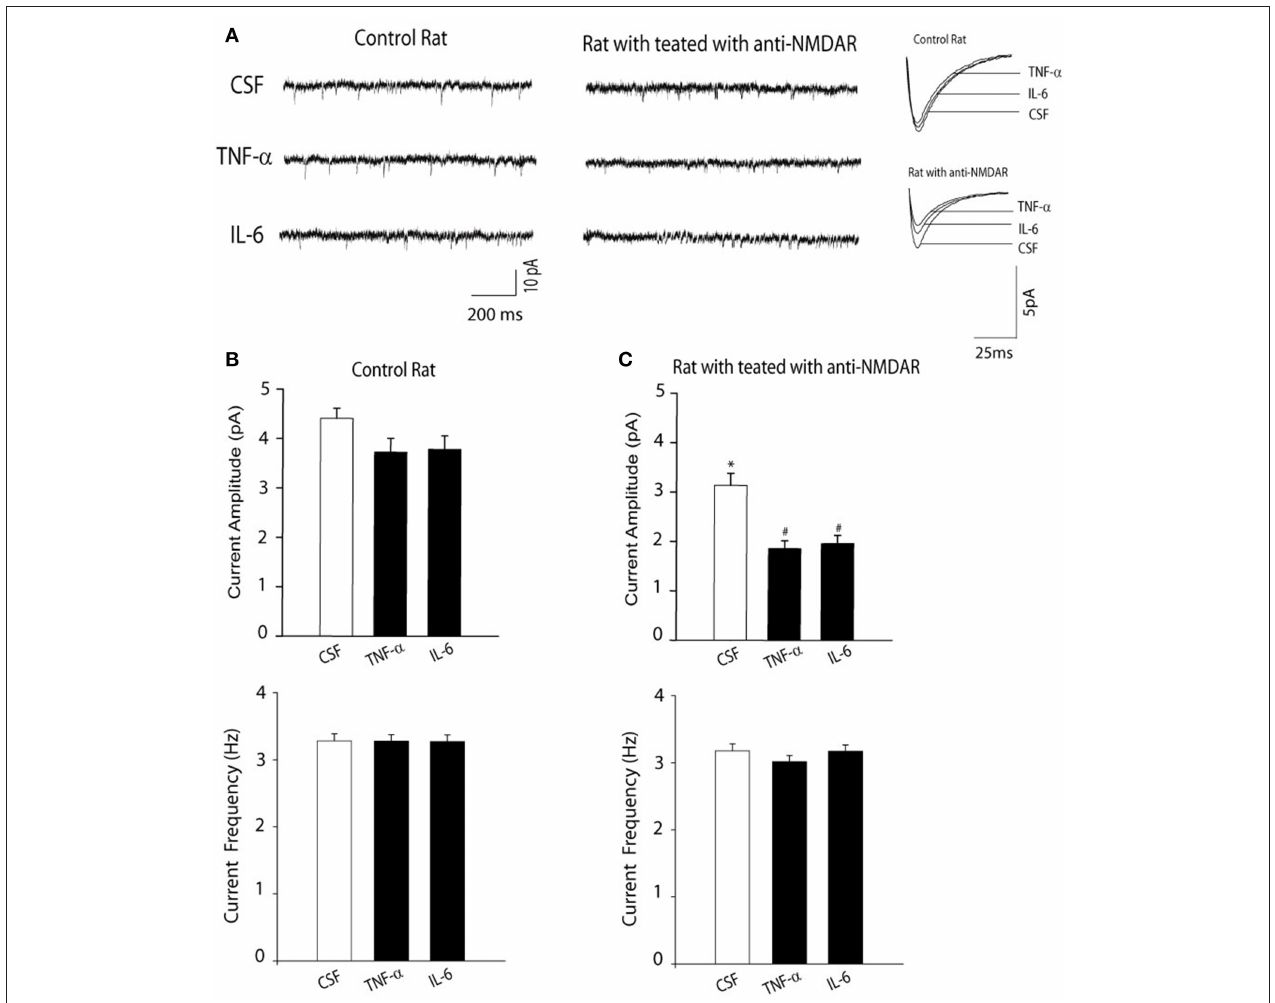
FIGURE 2 | (A) Representative traces and (B,C) averaged data showing amplitude of NMDAR-mediated mEPSCs was decreased in the hippocampal neurons of rats with anti-NMDAR. The frequency of NMDAR-mediated mEPSCs was not altered. The decreases in NMDAR-mediated mEPSCs became greater in the hippocampal neurons of rats with anti-NMDAR after the prior infusion of TNF- α or IL-6. The effects of TNF- α or IL-6 were observed to be insignificant in control animals. * P < 0.05 vs. control rats with CSF; and # P < 0.05, TNF- α /IL-6 vs. CSF in rats with anti-NMDAR. The number of neurons = 10–15 in each group of